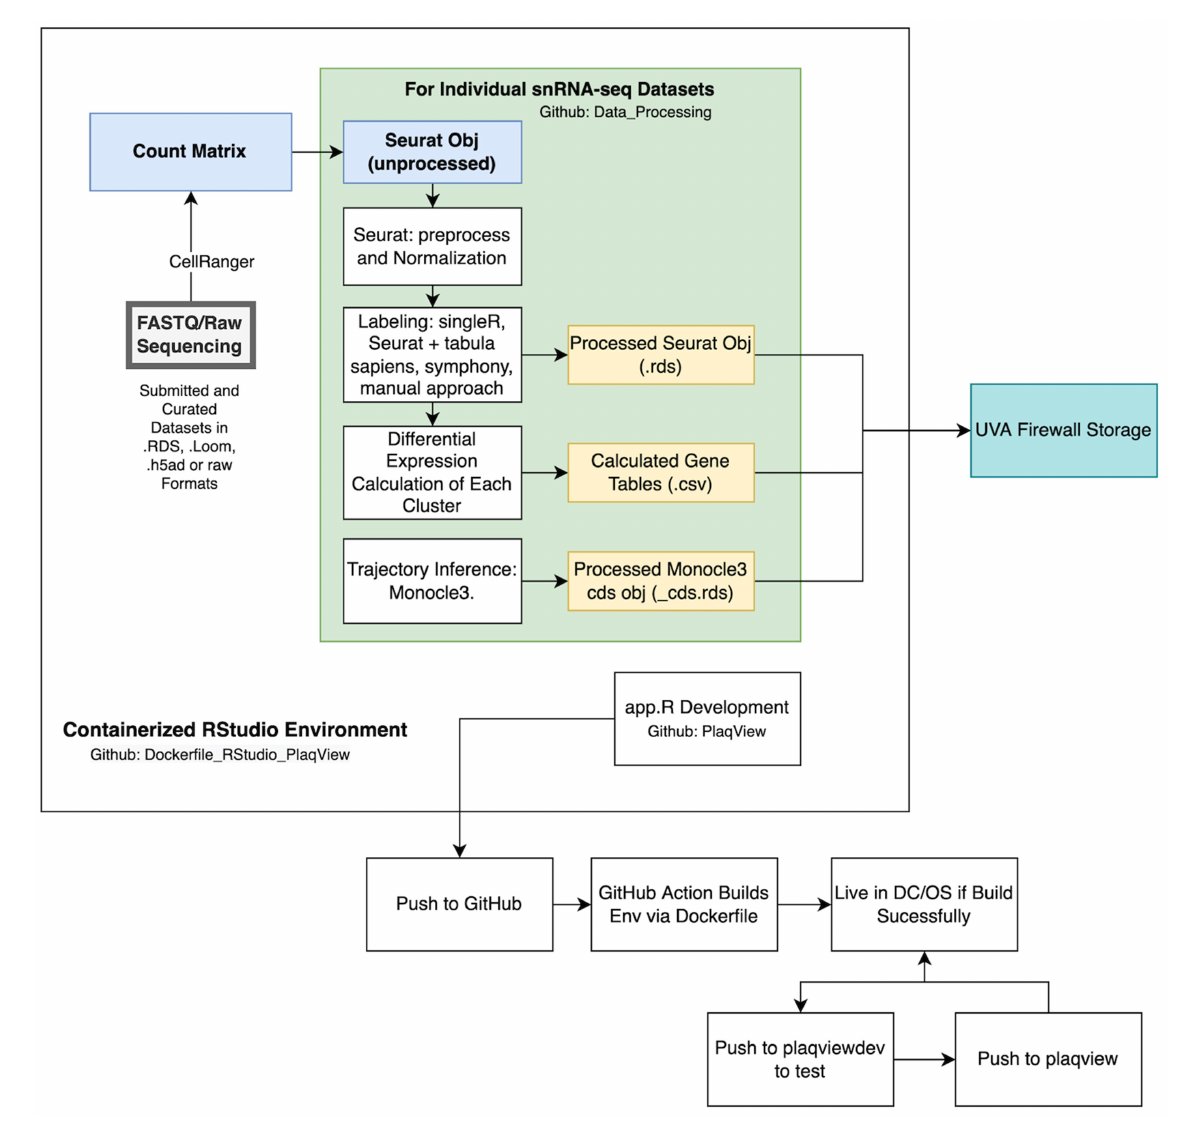
FIGURE8 Overview of data processing and programmatic strategy for PlaqView. Data submitted to PlaqView are processed systematically and stored as Seurat.rds objects. These objects, along with calculated differential gene expression tables and trajectories, are stored in secured storage provided by the University of Virginia. Additionally, app development and data processes are all conducted in a cataloged, stable Docker RStudio environment that is registered both on GitHub and